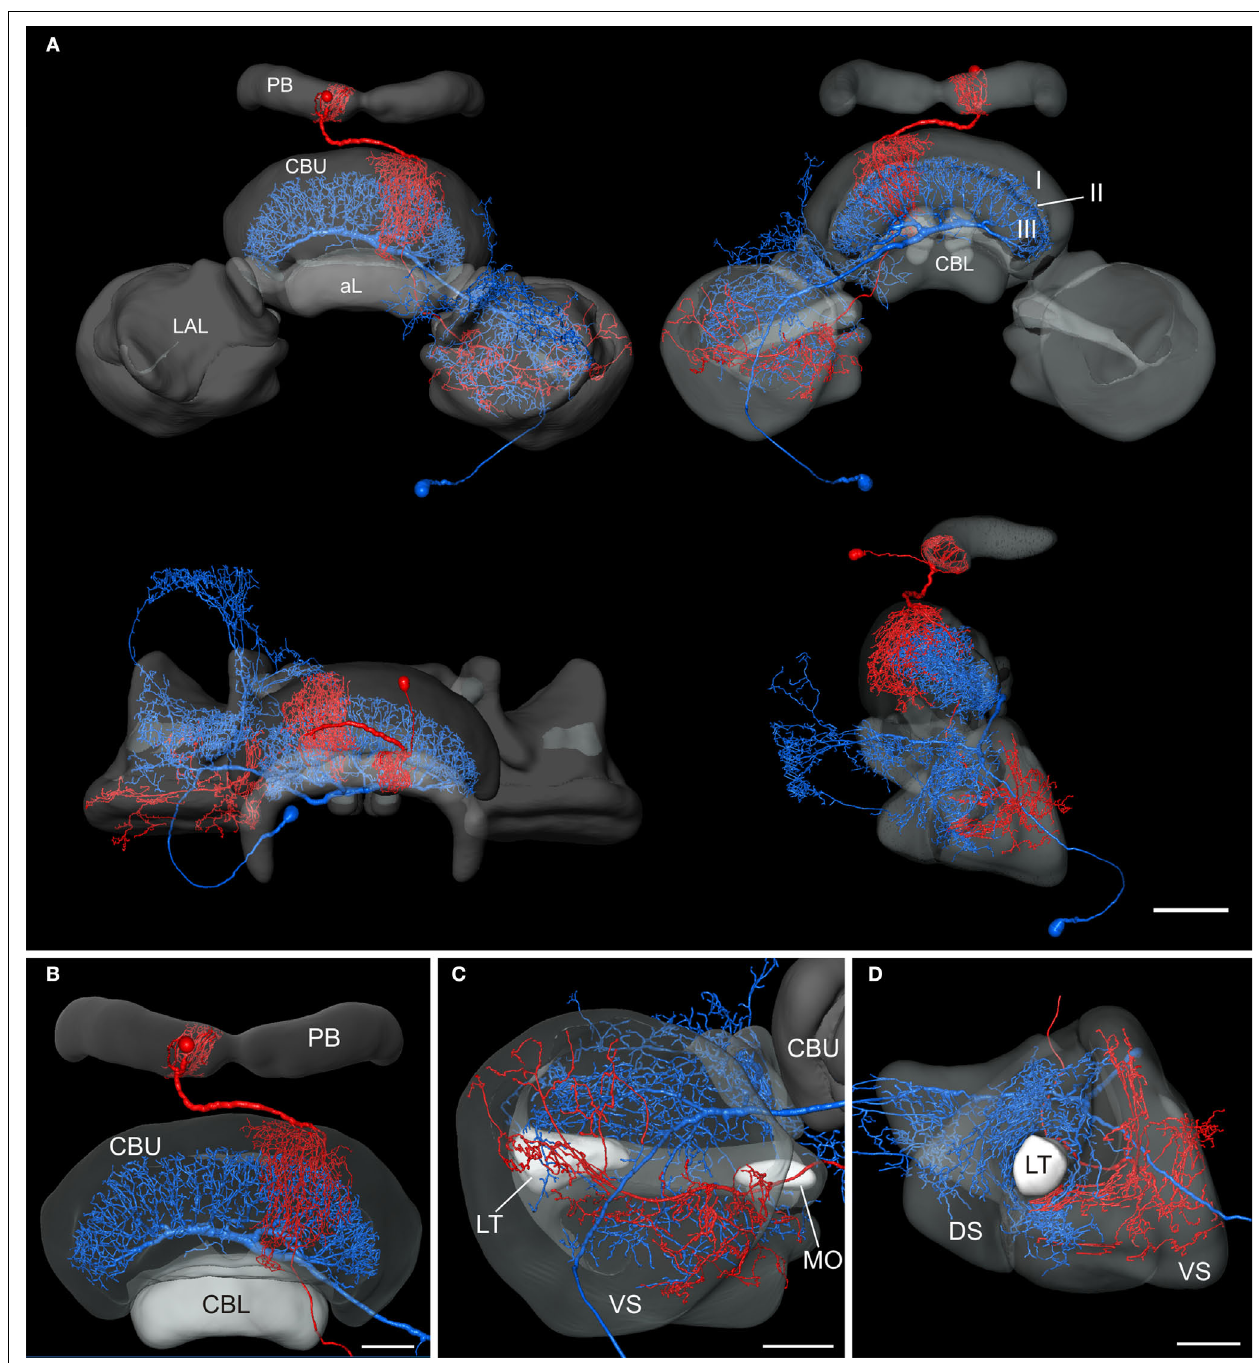
FIGURE 7 | Registration of the CPU1a ( red ) and GFS ( blue ) neurons into the 3D standard central complex. (A) Anterior view (top left), posterior view (top right), dorsal view (bottom left) and lateral view (bottom right). (B) Anterior view showing arborizations in the upper division of the central body ( CBU ) and in the protocerebral bridge ( PB ). (C) Posterior view of the standardized right lateral